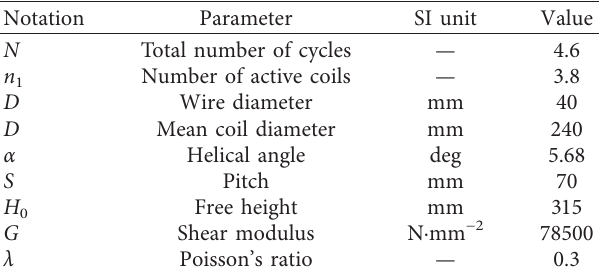
Table 2: Parameters of the coil